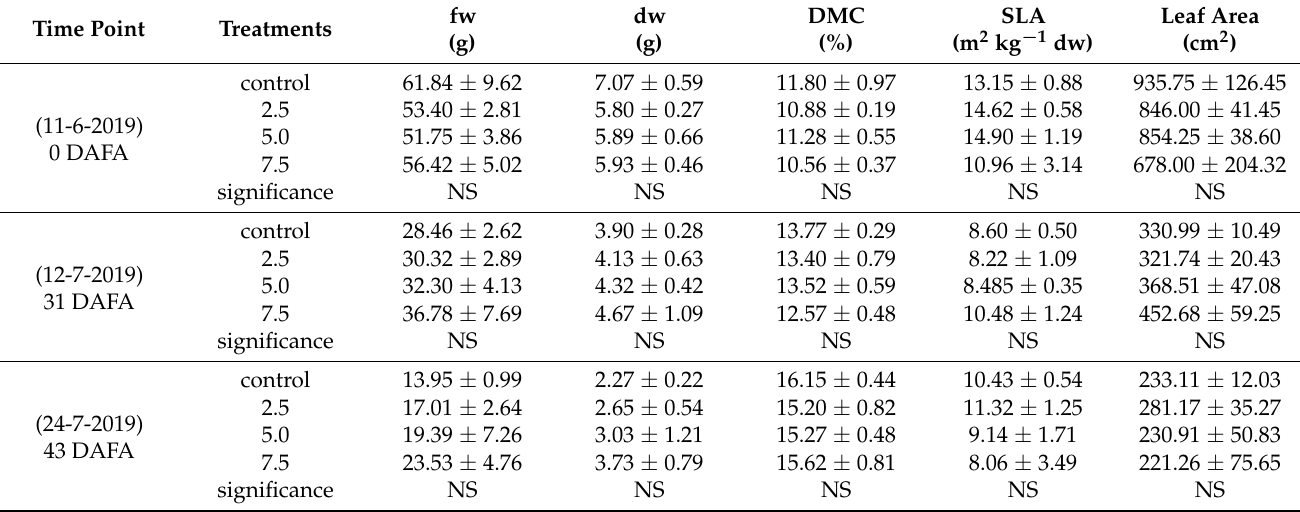
Table 2. Estimation of fresh weight (fw), dry weight (dw), dry matter content (DMC, %), specific leaf area (SLA) and leaf area (cm 2 ) in the collected leaf